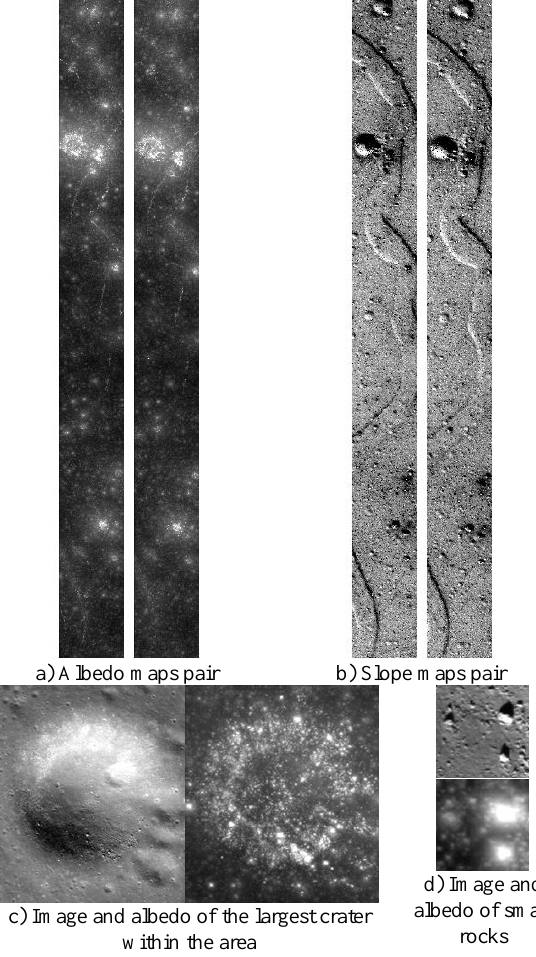
Figure 7. Albedo maps and slope maps of the image pair derived by the proposed photoclinometric process